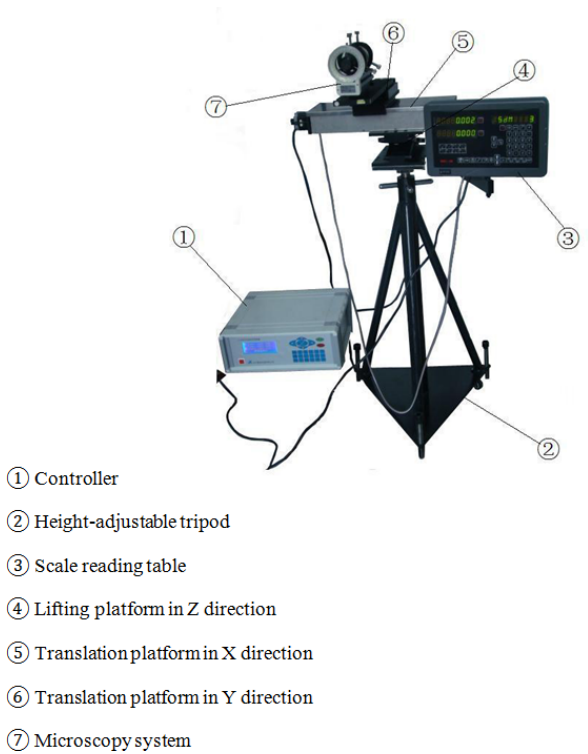
Figure 9: Schematic diagram of JCXE-DF wide range microscope